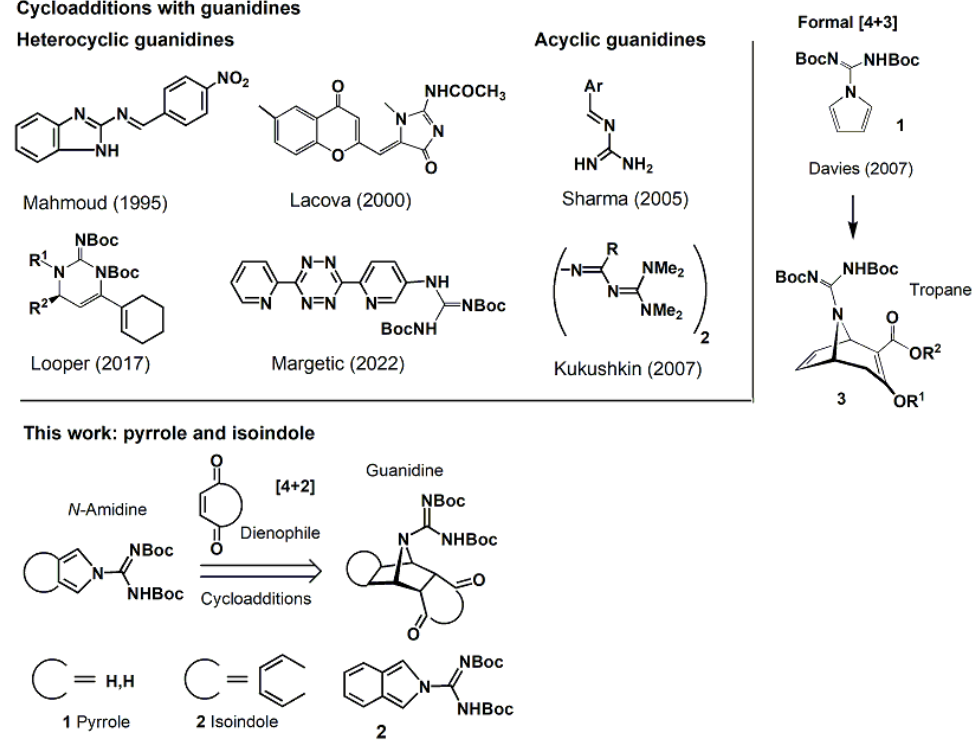
Figure 1. Used guanidines in Diels–Alder reactions and 2-carboxamidine dienes described in this work [6,7,13 ].